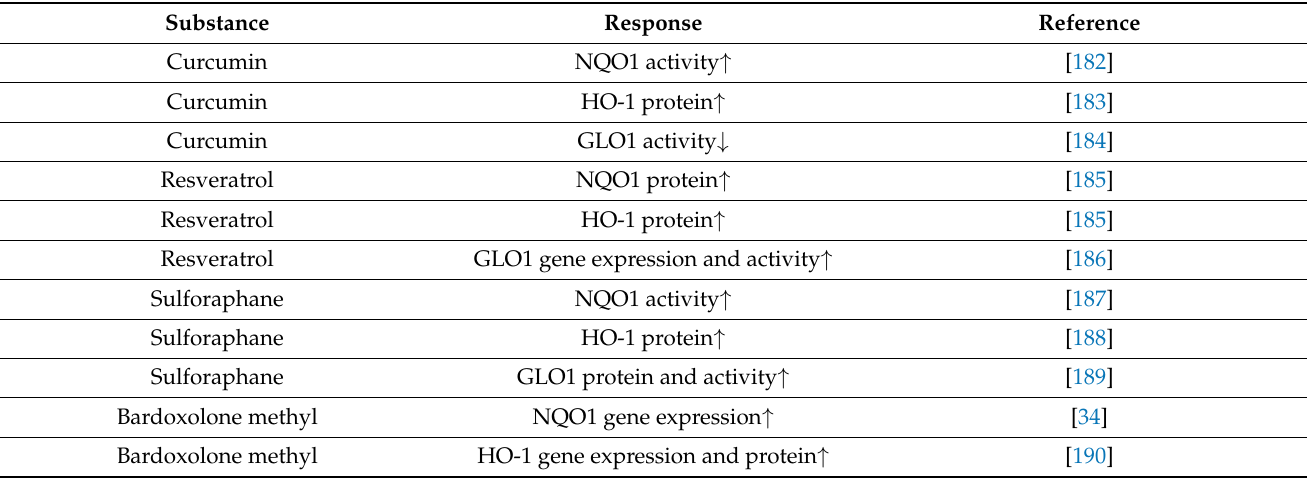
Table 4. Examples of molecular responses to pharmacological Nrf2 activation in non-CKD pa- tients/models or